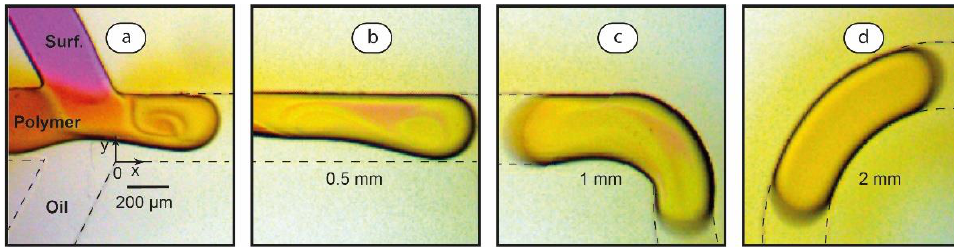
Figure 5. Optical microscopy images of SDS, PDADMAC, and hexadecane flows: droplet formation ( a ) and break-up ( b ), continuing mixing of solutions ( c ) and complete mixing ( d ). U = 30 mm/s, Ca ≈ 0.005, and φ = 0.1. Dyes (phenolphthalein + 0.01 M KOH and iodine) were added to surfactant and polymer solutions, respectively, for visualization. Dashed lines mark microchannel boundaries.